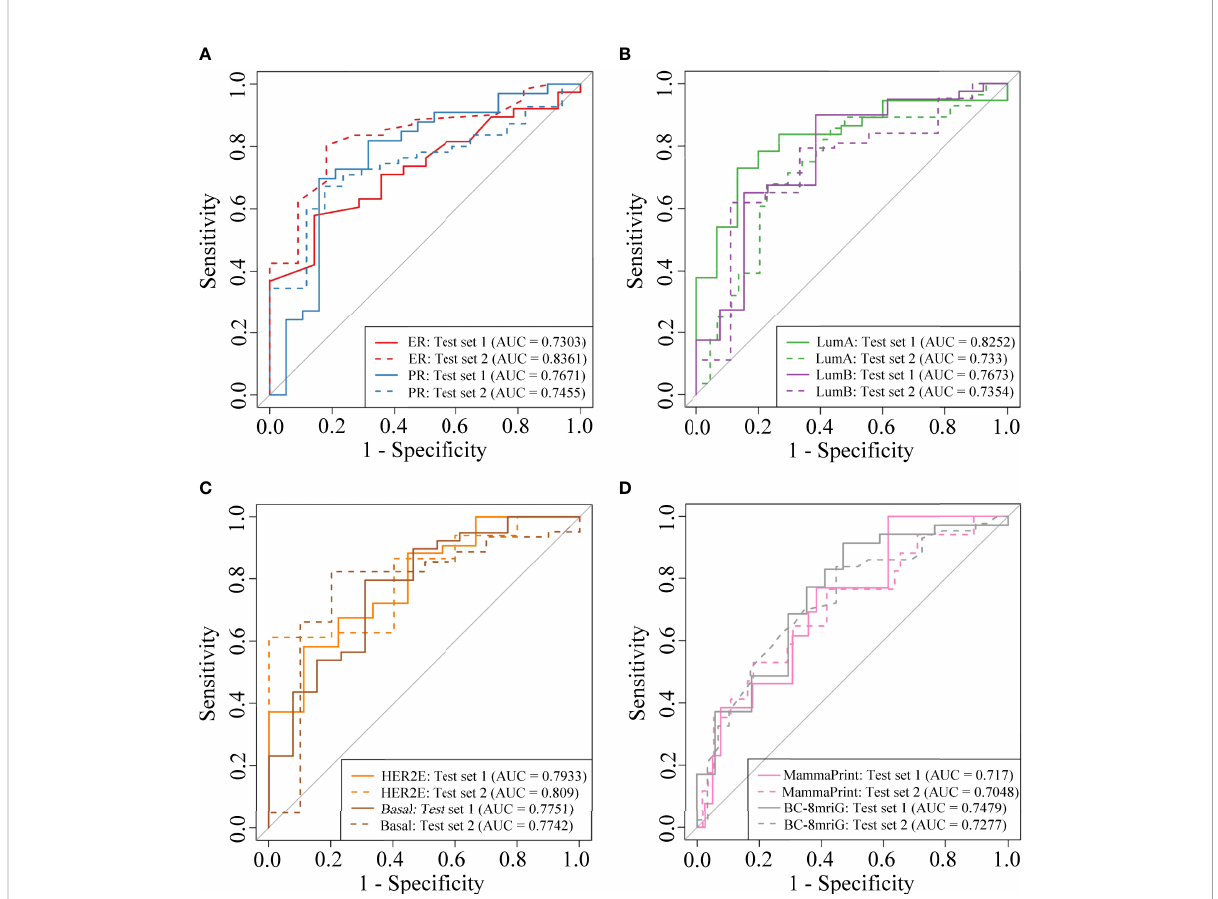
FIGURE 4 The model performance in two independent test sets. The ROC curves of the classi fi ers for ER status, PR status (A) , PAM50 luminal-A, luminal-B (B) , HER2-enriched, basal-like (C) , MammaPrint, and BC-8mriG (D) in the two cohorts. ROC, receiver operating characteristic; ER, estrogen receptor; PR, progesterone receptor; HER2, human epidermal growth factor receptor